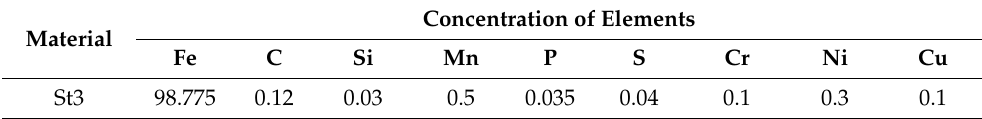
Concentration of